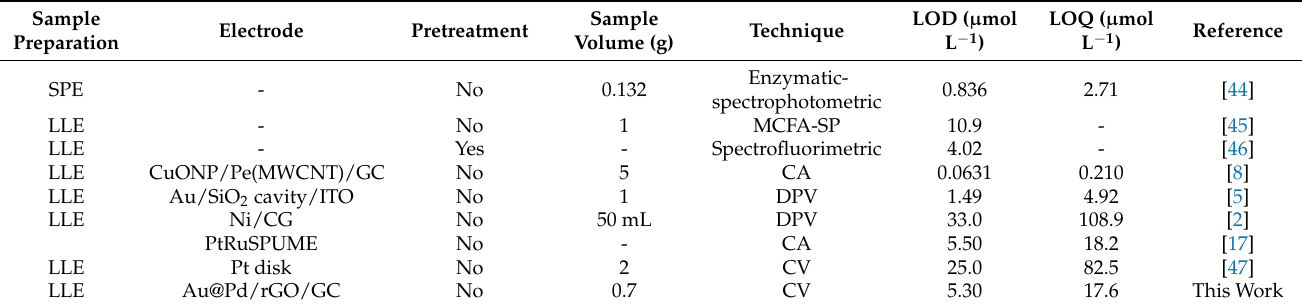
Table 3. Comparison of the proposed electrode with others in the